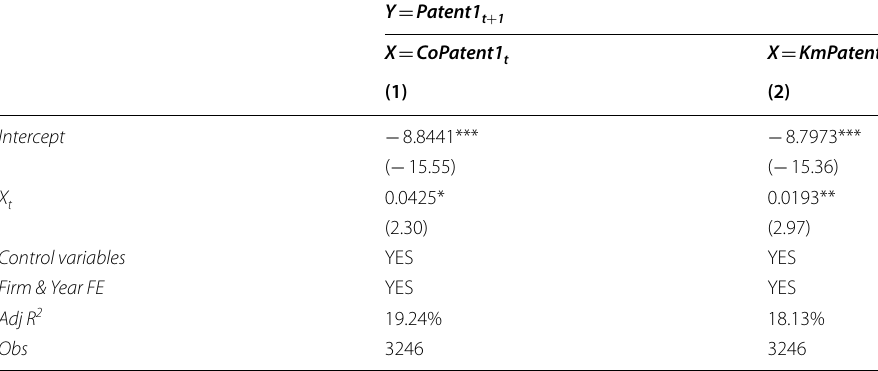
This table presents the regression results of the overall sample in regression (5). We have replaced RD1 for Patent1 . Column (1) and (2) respectively shows the regression results of two explanatory variables on the dependent variable. Firm fixed effects and year fixed effects are controlled in the regression. The T statistic is in parentheses under the coefficient.*, **, and *** mean statistical significance at 5%, 1%, and 0.1%